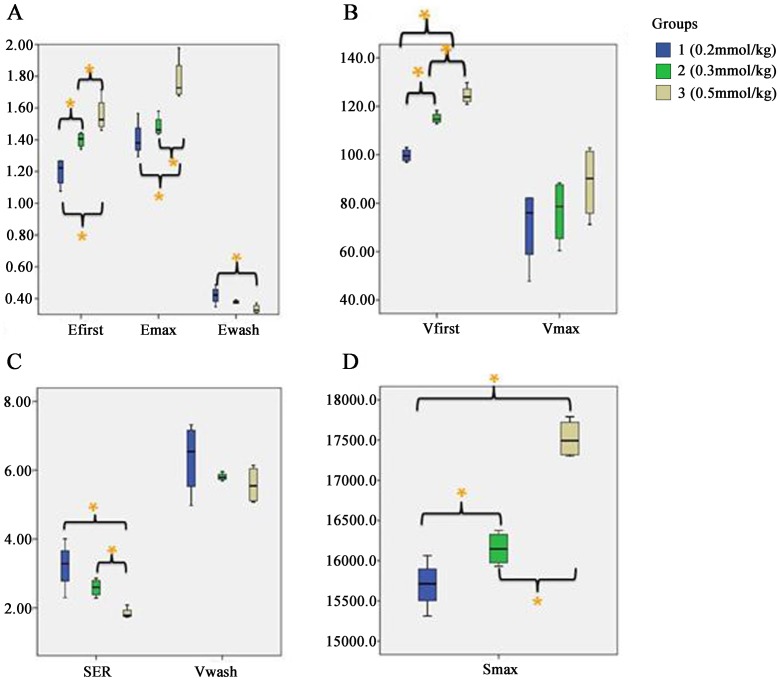
Box plots illustrating the influence of the CA dosage on several semi-quantitative parameters.The results of the pairwise comparisons are also shown in this figure. (A)Efitst, Emax, and Ewash; (B)Vfirst and Vmax; (C)SER and Vwash; (D)Smax. Some parameters that unaffected by the dosage variation, such as Slopewash and Tpeak are not shown. *The difference between two groups is significant (p<0.05).